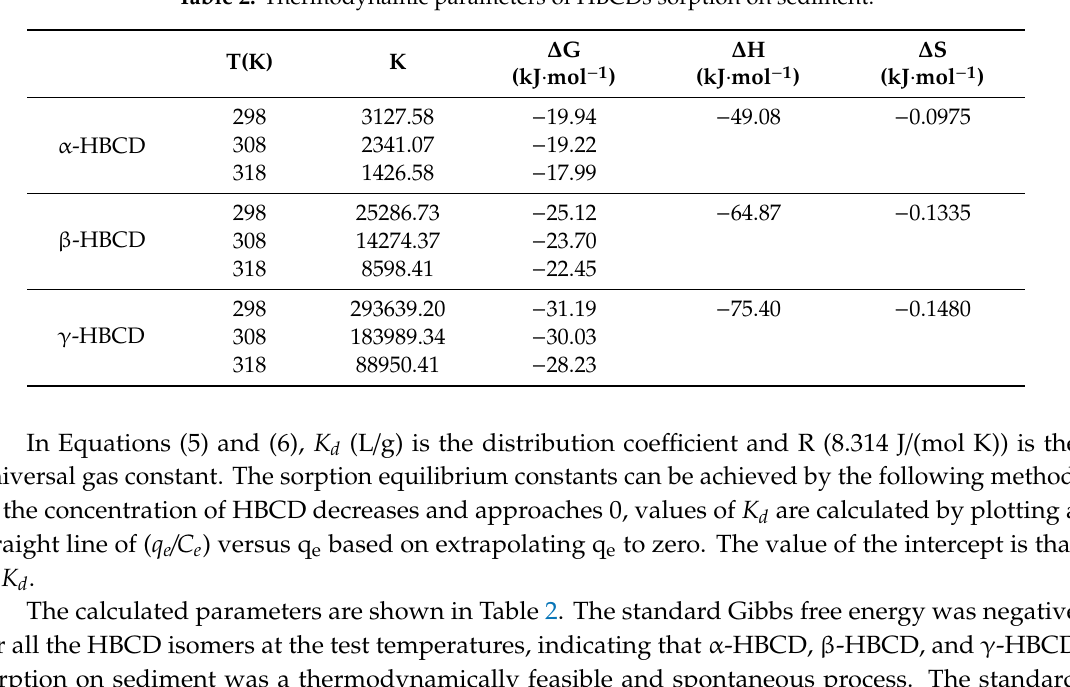
Table 2. Thermodynamic parameters of HBCDs sorption on